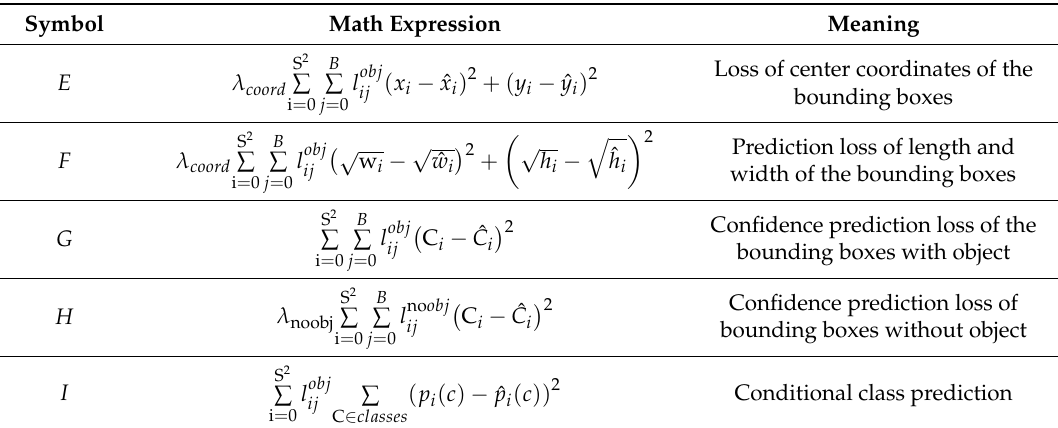
Table 3. Definition of the loss